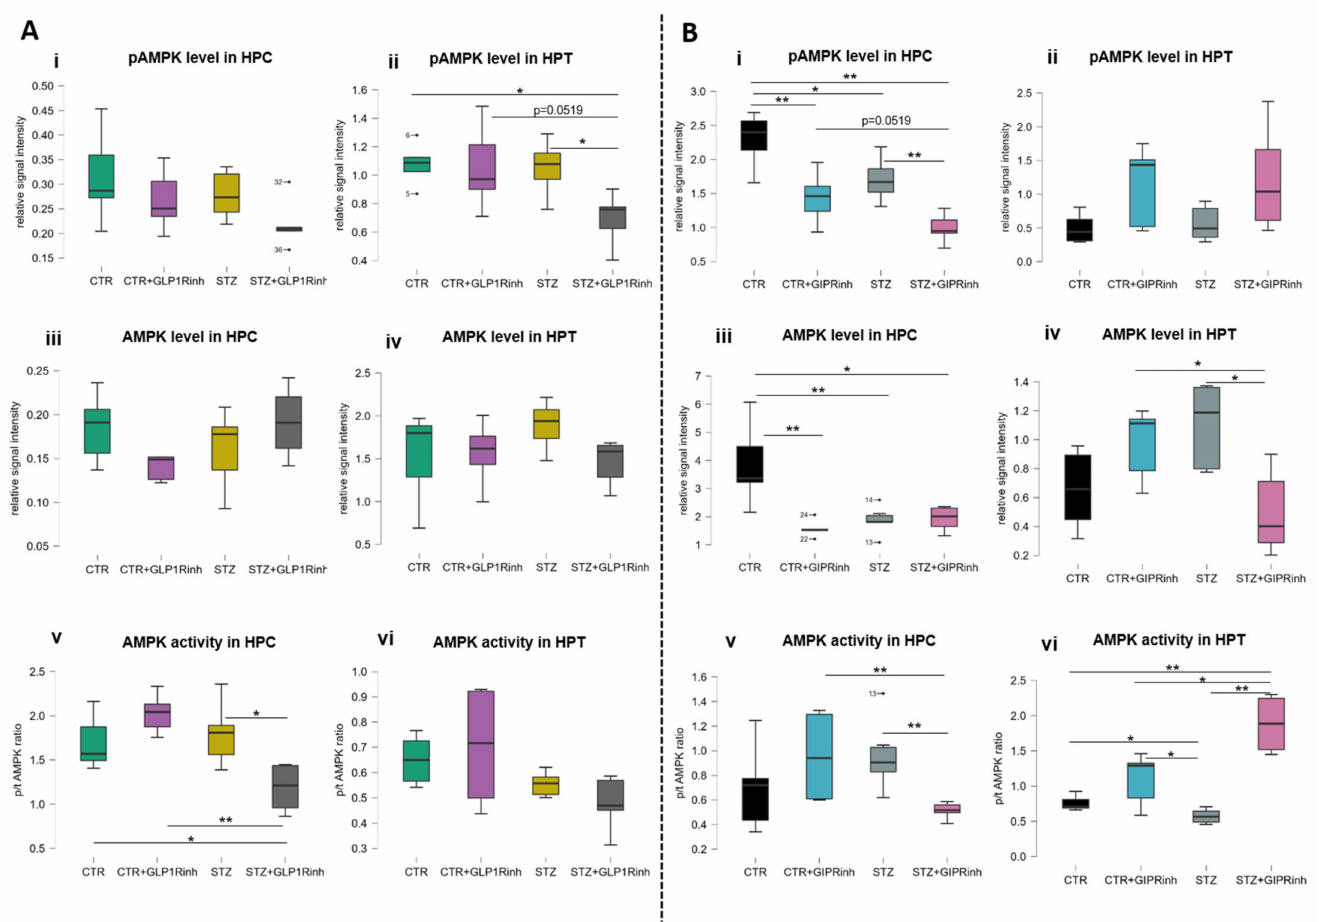
Figure 4. Levels and activity of AMP-activated protein kinase in the hippocampus and hypothalamus changed after central glucagon-like peptide-1 and gastric inhibitory polypeptide inhibition. One month after intracerebroventricular (icv) streptozotocin (STZ) or vehicle (CTR) administration, rats were injected icv with 85 µ g/kg of glucagon-like peptide-1 receptor antagonist (Exendin fragment 9–39, GLP1Rinh; experiment 1) or 85 µ g/kg of gastric inhibitory polypeptide receptor antagonist (Pro3-GIP, GIPRinh; experiment 2) dissolved in saline or with saline only (CTR and STZ). Animals were sacrificed 30 min after icv administration and the hippocampus (HPC) and hypothalamus (HPT) were dissected, homogenized/sonicated, and protein concentration was measured. Phosphorylated (Thr172) and total AMP-activated protein kinase (pAMPK ( i , ii ) and tAMPK ( iii , iv )) levels in the HPC and HPT were measured by Western blot analysis 30 min after central GLP1R ( A ) and GIPR ( B ) inhibition. AMPK activity is expressed as a ratio between pAMPK and tAMPK ( v , vi ). Values are presented as boxplots with marked outliers and data analyzed by a non-parametric Kruskal–Wallis one-way ANOVA test followed by a Mann–Whitney U test (* p < 0.05; ** p <